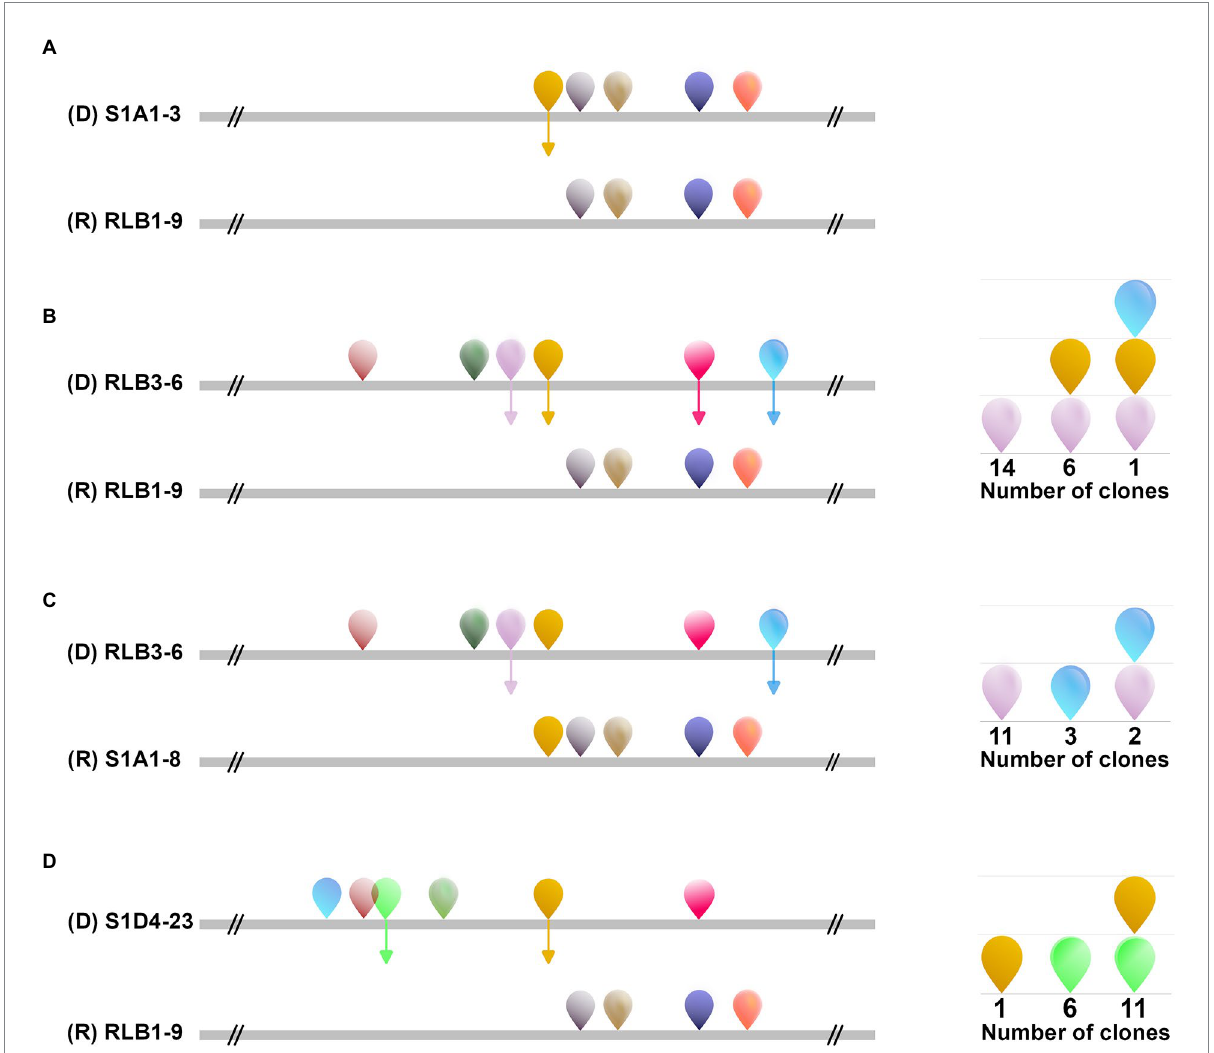
FIGURE 7 Multiple AICE transfer during a single mating event. The transfer spectrum of AICEs within pocks between four different strain couples [ (A) : S1A1- 3/RLB1-9, (B) : RLB3-6/RLB1-9, (C) : RLB3-6/S1A1-8 and (D) : S1D4-23/ RLB1-9] was assessed by PCR amplification of regions specific to each element. The strain represented at the top of each couple was the donor strain. The position and the family of the different elements present in both the donor and the recipient strains are schematized as in Figure 1. Depending on the couple, transfers from one to four different AICEs were identified, represented by the colored arrows. As a pock represents a population of different cells that could have experienced different AICE transfers, it was not possible at this stage to conclude whether multiple AICE transfers were the result of the concomitant transfer of several AICEs between the donor and a single recipient, or of multiple individual transfers between the donor and different recipient cells in the pock. After isolation of individual clones from a pock, both single and multiple AICE transfers were revealed in recipient cells. The schemes on the right-hand side represent which AICE was identified and revealed that a single strain can receive one to three different AICEs D: donor strain; R: recipient